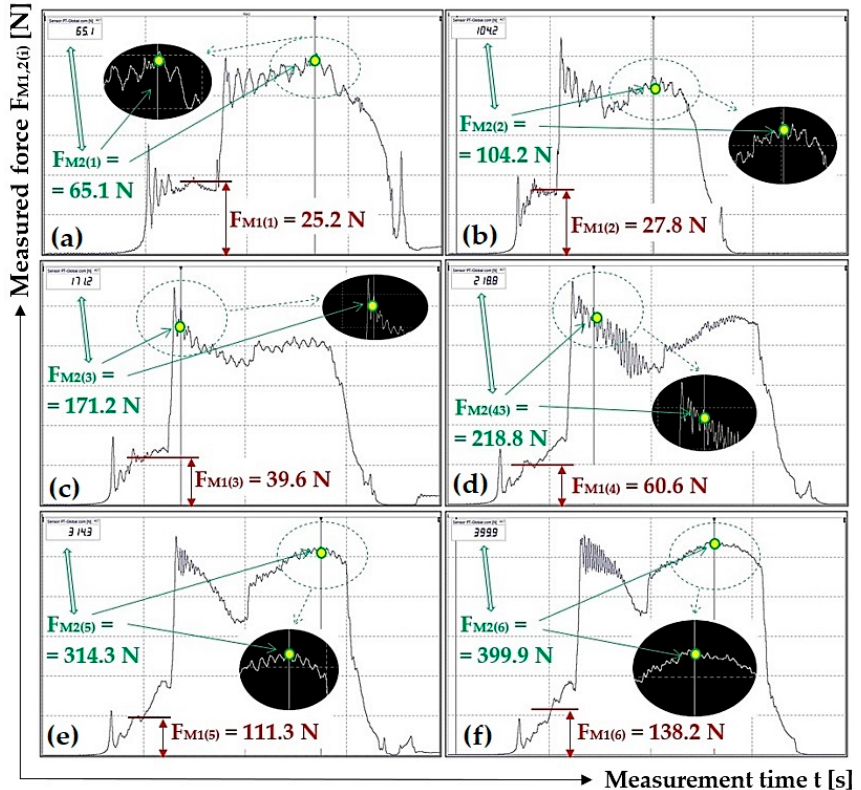
Figure 7. Tensile forces measured using DeweSoft ® software for different load weights at the scraper plough angle of inclination β = 20 deg.